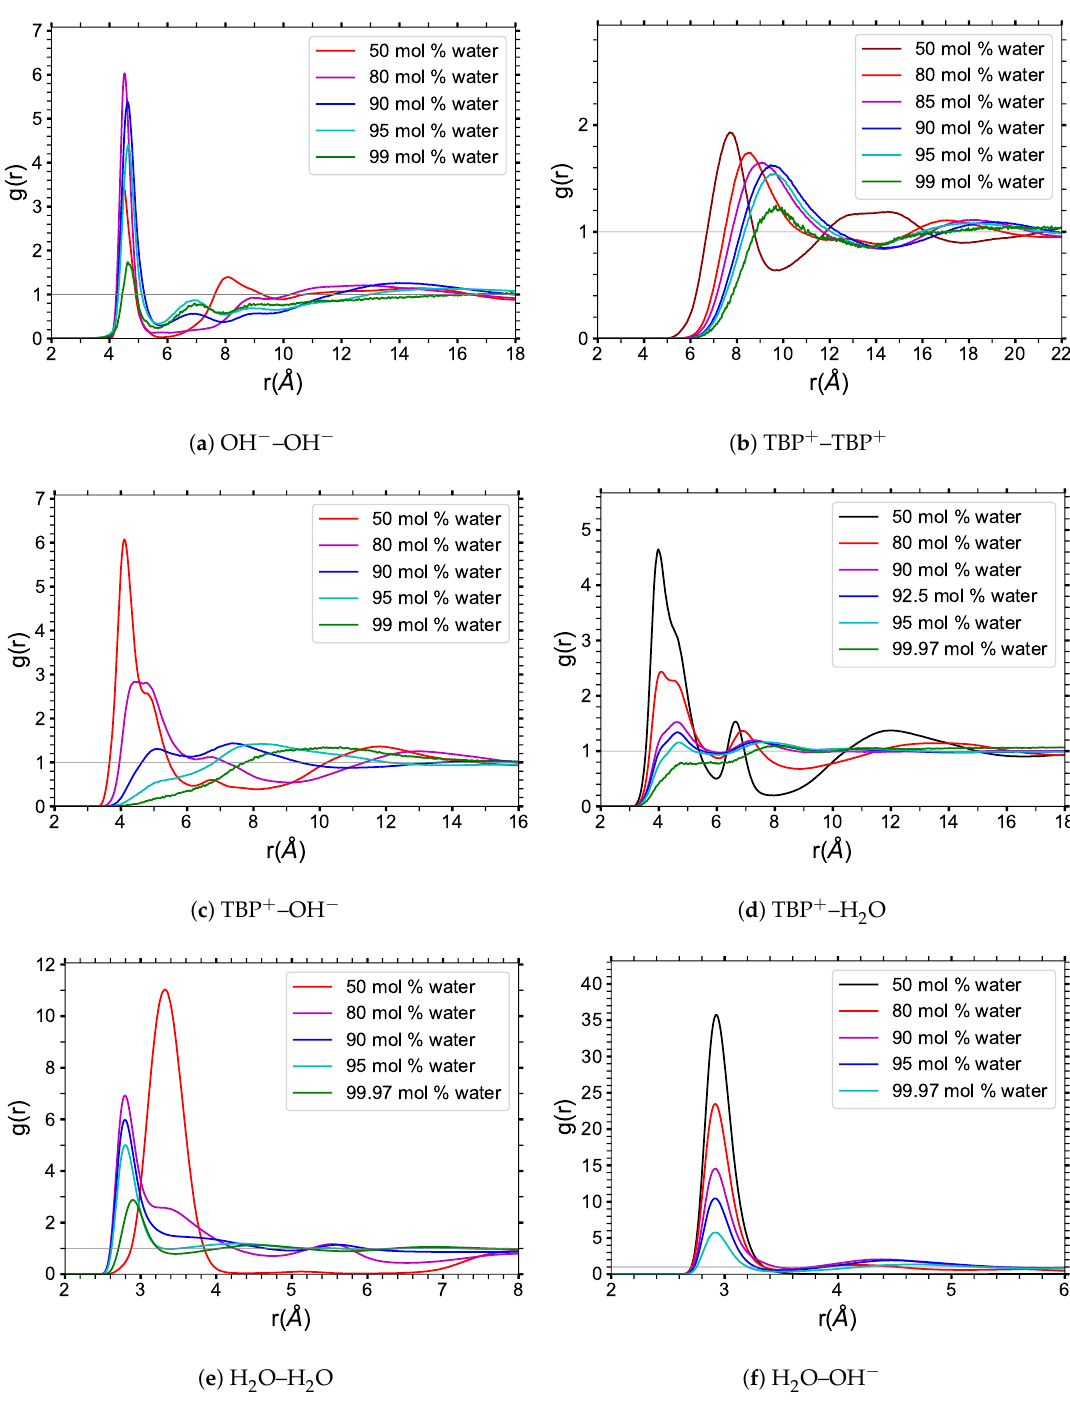
Figure 4. Radial distribution functions of TBPH–water at 300K for various indicated water concentrations. The radial distribution functions are between the following molecules: ( a ) OH − –OH − ; ( b ) TBP + –TBP + ; ( c ) TBP + –OH − ; ( d ) TBP + –H